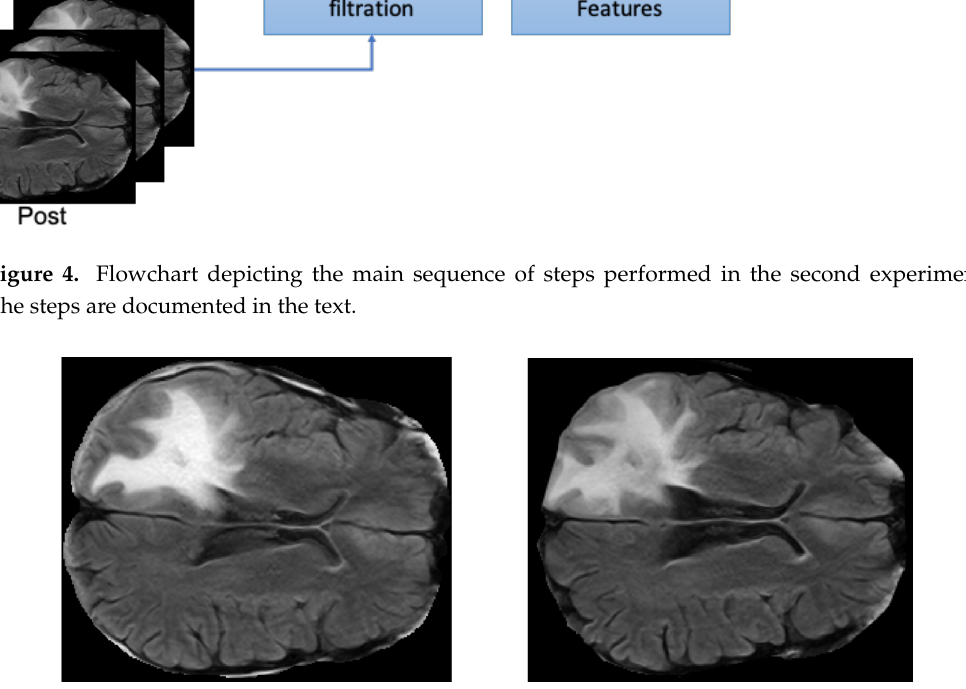
Figure 5. Example of two slices from FLAIR for the same patient within 90 days following chemo-radiation therapy (CRT) completion and at